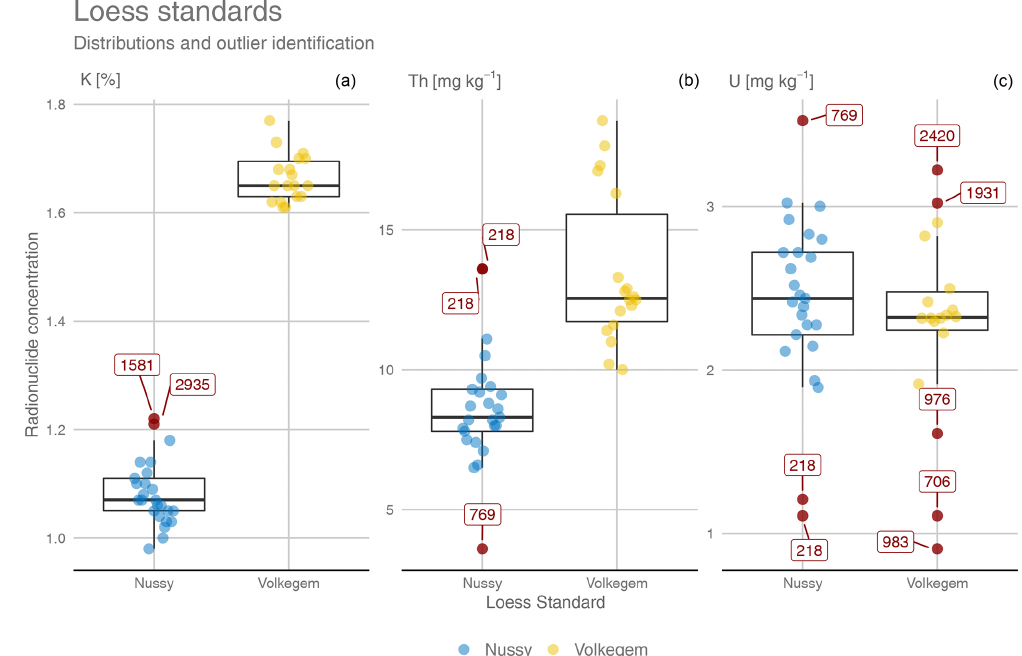
Figure 6. Radionuclide concentrations determined by µ Dose measurements given as percent for K (a) and as milligrams per kilogram (mgkg − 1 ) for Th (b) and U (c) . The different colours represent the different loess standards investigated (see legend). Outliers (red circles) were identified based on the 1.5 IQR criterion and are labelled with their respective number of total α counts. Table 9. Median values and relative standard deviations (RSDs) for radionuclide concentrations of the loess standards Nussy (upper part) and Volkegem (lower part) derived from µ Dose measurements. The individual measurements were classified into three groups of measurement durations based on the total number of α counts (short-time group: < 2000 α counts; medium-time group: 2000–4000 α counts; long-time group: > 4000 α